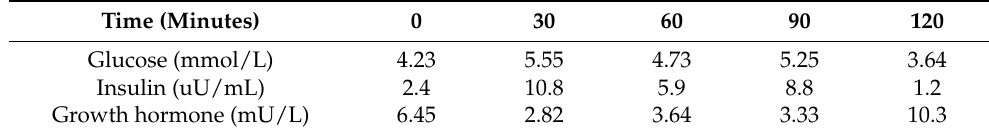
Table 2. Oral glucose suppression test